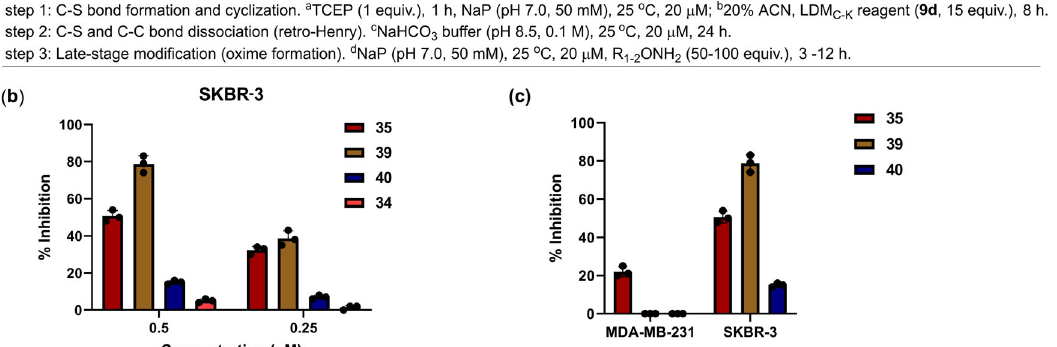
Kadcyla ( 40 ) in SKBR-3 (HER-2 positive) cancer cell line. The percentage inhibition was calculated using untreated cells as control. c Inhibition of cell proliferation by DM1 ( 35 ), ADC ( 39) , and Kadcyla ( 40 ) at 0.5nM concentration in HER-2 positive SKBR-3 as compared to HER-2 negative MDA-MB-231 cells. Data are presented as mean values (±SD), n =3 biologically independent